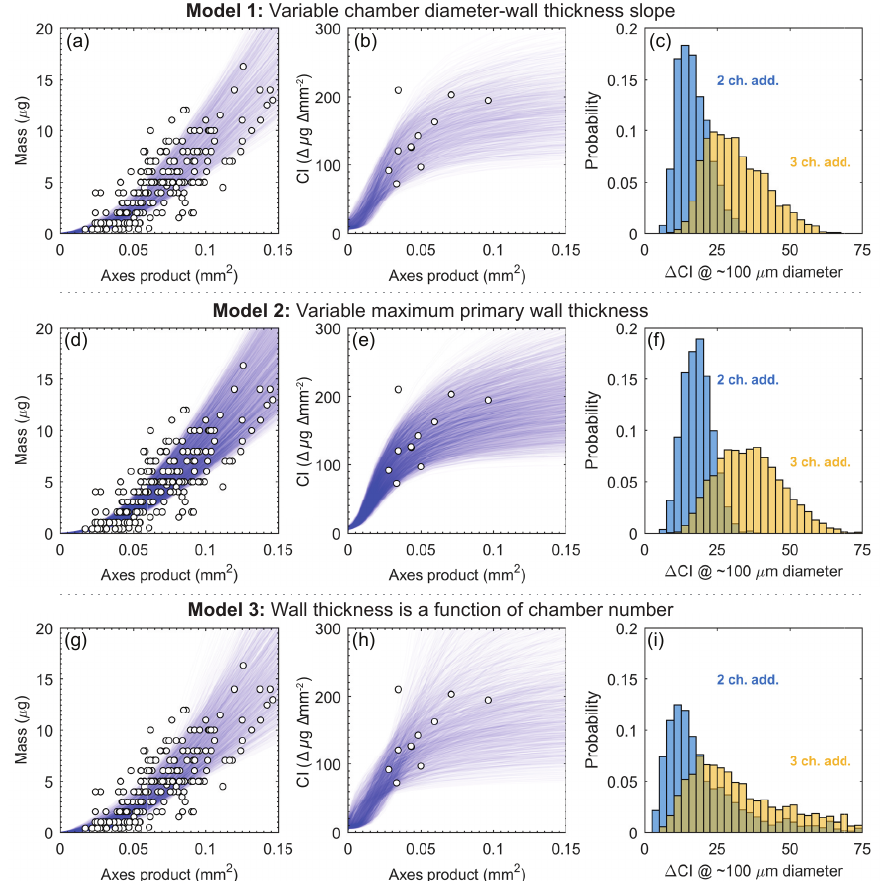
Figure 1. Model output for the three model scenarios described in Sect. 2.4.2. (a) Measured size–mass relationship for G. ruber based on towed specimens from the Gulf of Eilat that were not cultured. The residual sum of squares between these data defines which model runs (individual blue lines) are taken as representative of this natural population. (b) CI data of cultured specimens (Eq. 2), shown in the context of that predicted from the same set of models for the scenario where two chambers were precipitated in culture. All models predict that CI is dependent on body size on collection, which is also our empirical observation. (c) Model CI dependence on the amount of chambers added in culture. Broadly, the more chambers precipitated, the higher the resultant measured CI. Because of this finding, we use the model relationship between CI and the number of chambers added in culture to normalise the culture CI data shown in panel (b) . Panels (d–i) show equivalent results when the model is set up in two alternative ways (see Sect. 2.4.2 and Appendix A1).